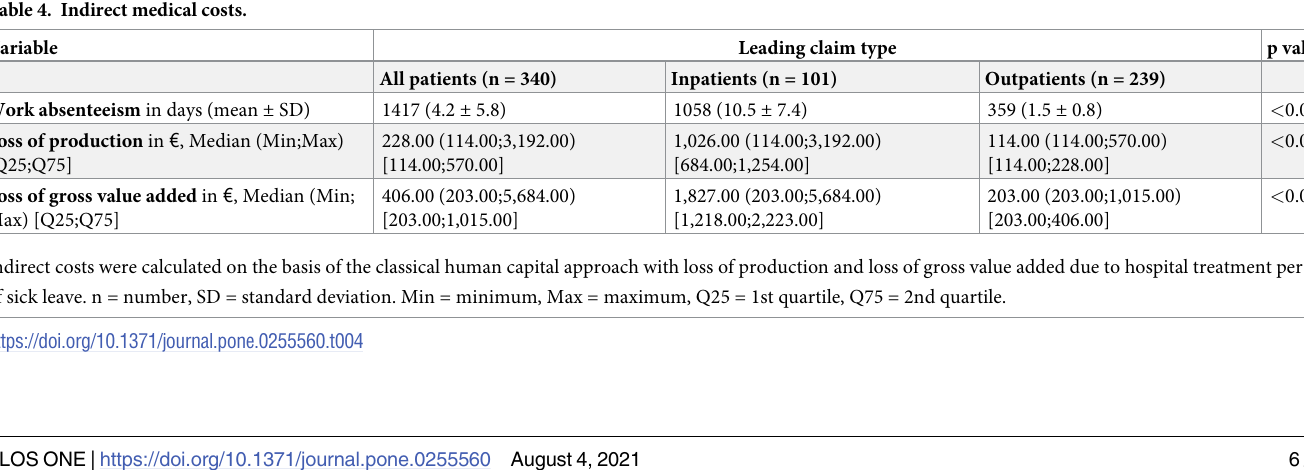
Direct non-medical costs. The direct non-medical costs consisted solely of the costs for the travelled distance between the place of residence and the Department of Dermatology (Table 3). The inpatient range was slightly larger with an average journey distance of 121.0 km ± 93.3 km compared to 87.6 km ± 73.5 km in the outpatient group. For the one-way dis- tance, the median cost factor was € 32.70 in the inpatient and € 20.55 in the outpatient group per patient per visit. Extrapolated to all visits or journeys to the University Hospital Wu¨rzburg, this amounted to € 110.25 for each inpatient and to € 26.34 for each outpatient for all visits in 2017. The difference between out- and inpatient costs was statistically significant (p < 0.001). Indirect medical costs. Indirect medical costs were assessed by means of loss of produc- tion (estimated based on labor costs) and loss of gross value added (estimated loss of labor pro- ductivity) due to hospital treatment. For both methods, the outage and associated costs are higher for the inpatients than for the outpatients. Accordingly, both calculation methods (Table 4).